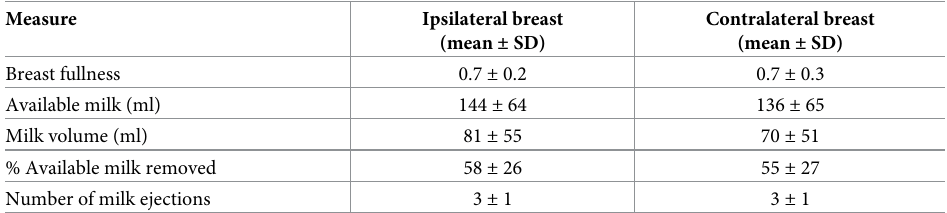
Table 2. Milk removal characteristics from the two monitored pumping sessions.